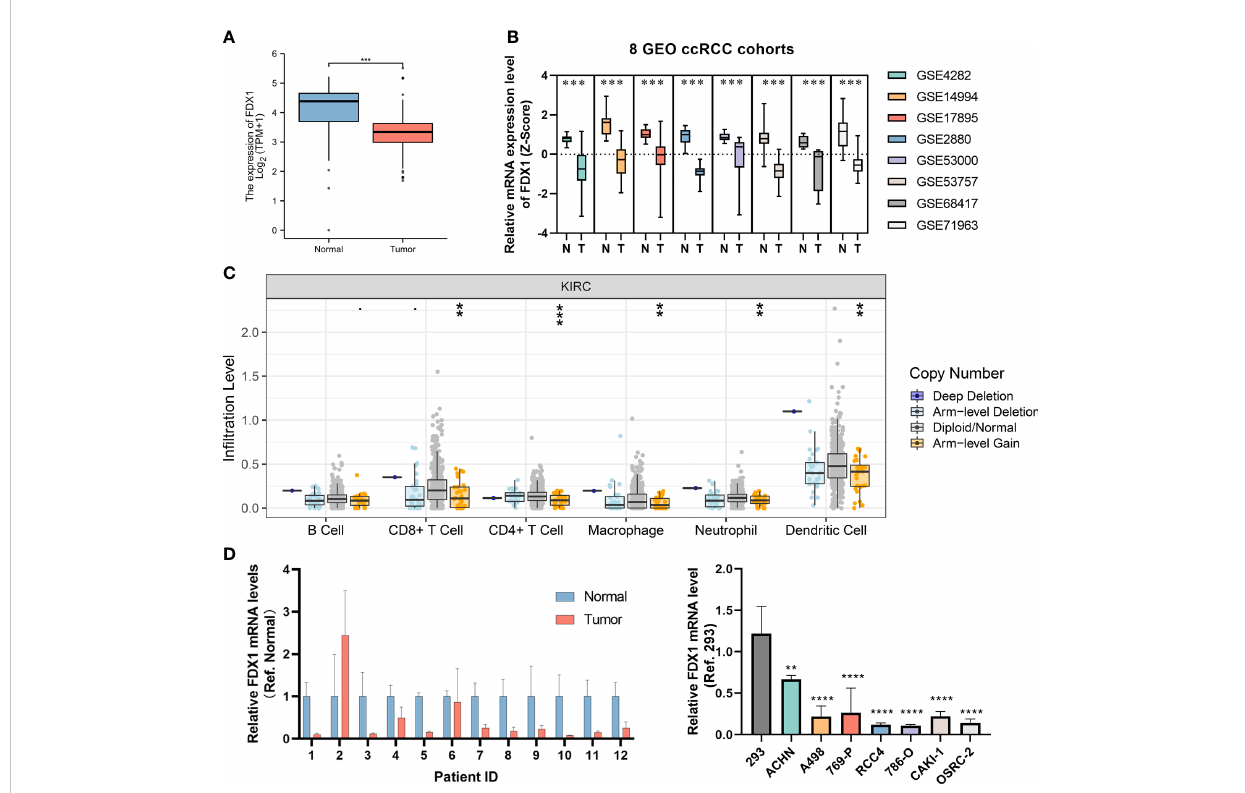
FIGURE 8 Further exploration of the FDX1. (A) The bar plot of the FDX1 mRNA expression between ccRCC and normal tissues in TCGA and GTEx database. (B) Analysis of 8 GEO datasets regarding FDX1 mRNA expression in ccRCC and normal samples. (C) The association of FDX1 CNV status with immune in fi ltration abundance in ccRCC was evaluated using TIMER database. (D) The validation of FDX1 mRNA expression level in our clinical specimens and cell lines. GP style: **: p < 0.01; ***:p<0.001; ****